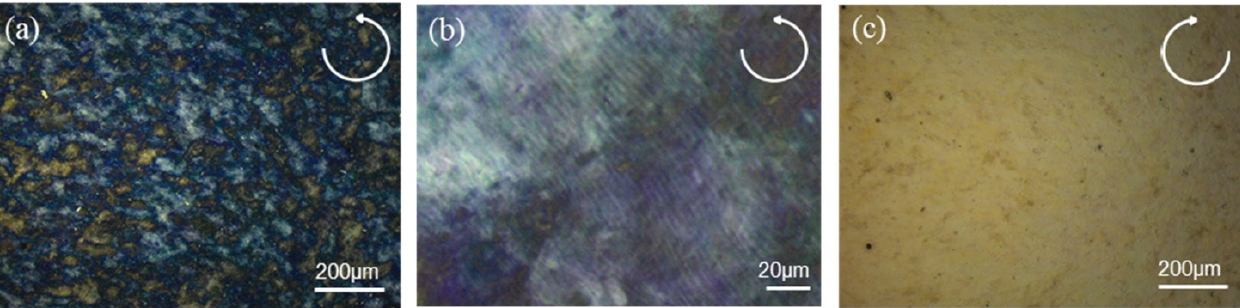
Figure 3. ( a ) POM of CNC/ZnO photodetector under the LCPL reflection mode. The characteristic finger texture in shown in ( b ). ( c ) POM of CNC/ZnO photodetector under the RCPL reflection mode.